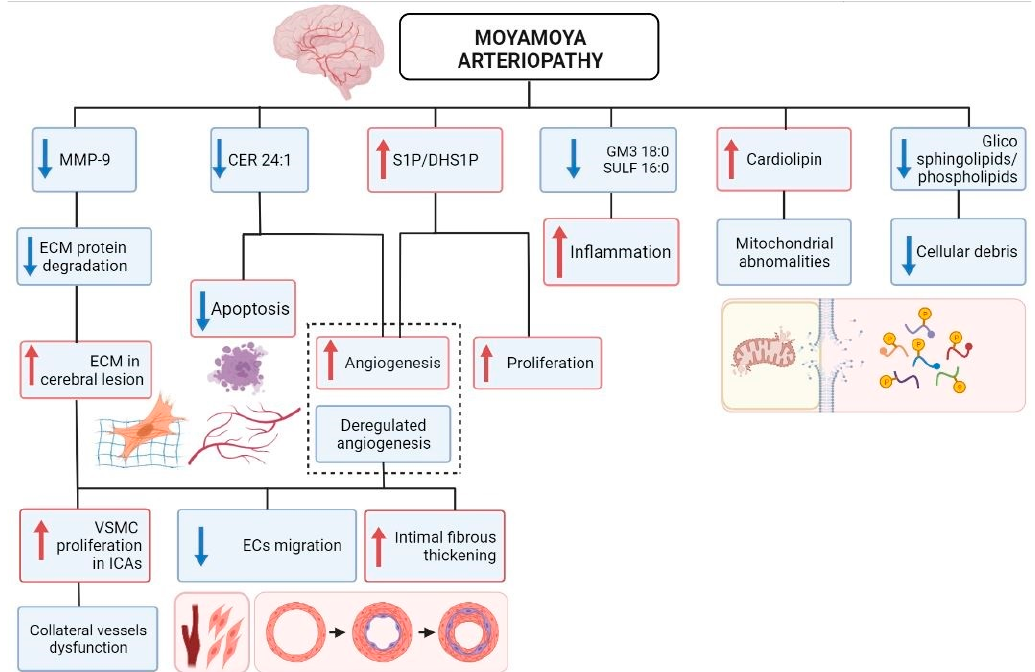
Figure 5. Map representing the main deregulated protein and lipid factors in MA plasma and the predicted associated biological effects. Red arrows indicate up-regulation of lipids or induction of associated biological effects; blue arrows indicate down-regulation of proteins/lipids or decrease of associated biological effects. Dotted line indicates the effects of reported deregulations on angiogenesis.